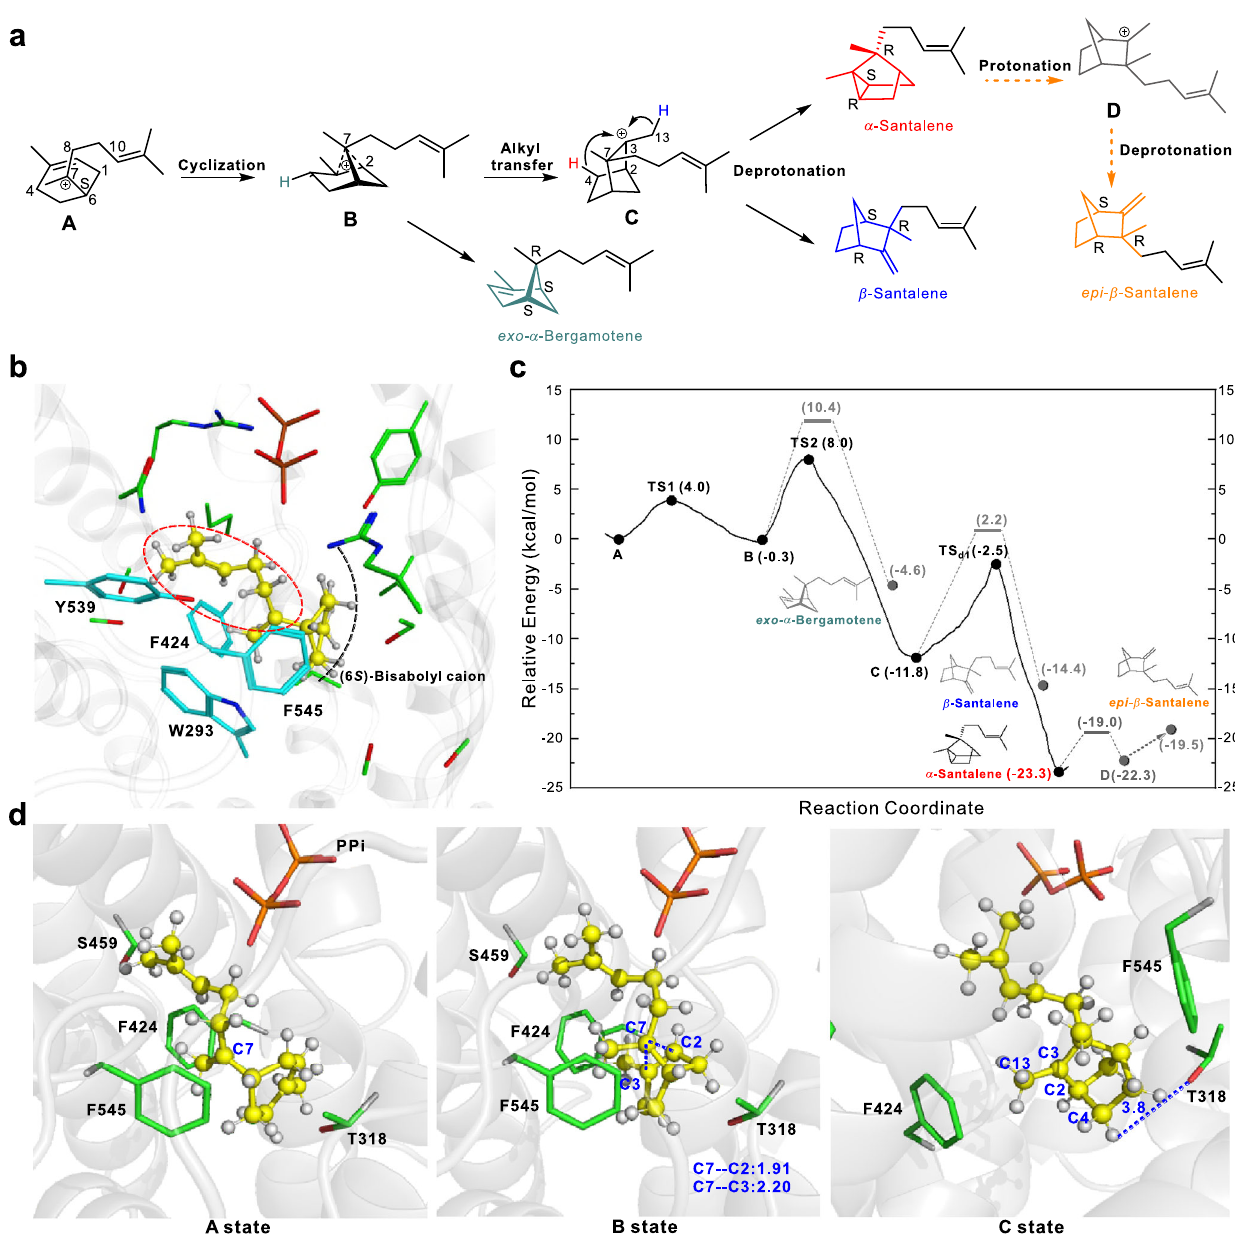
Fig. 2 QM/MM MD simulation of the reaction pathway catalyzed by SaSSy. a The reaction pathway from (6 S )-bisabolyl cation (A state) to the multiple products. b A state in the active site of SaSSy model. c Relative energy pro fi les from A state to α -santalene. d Representative structures of QM/MM simulations for A, B, and C states are